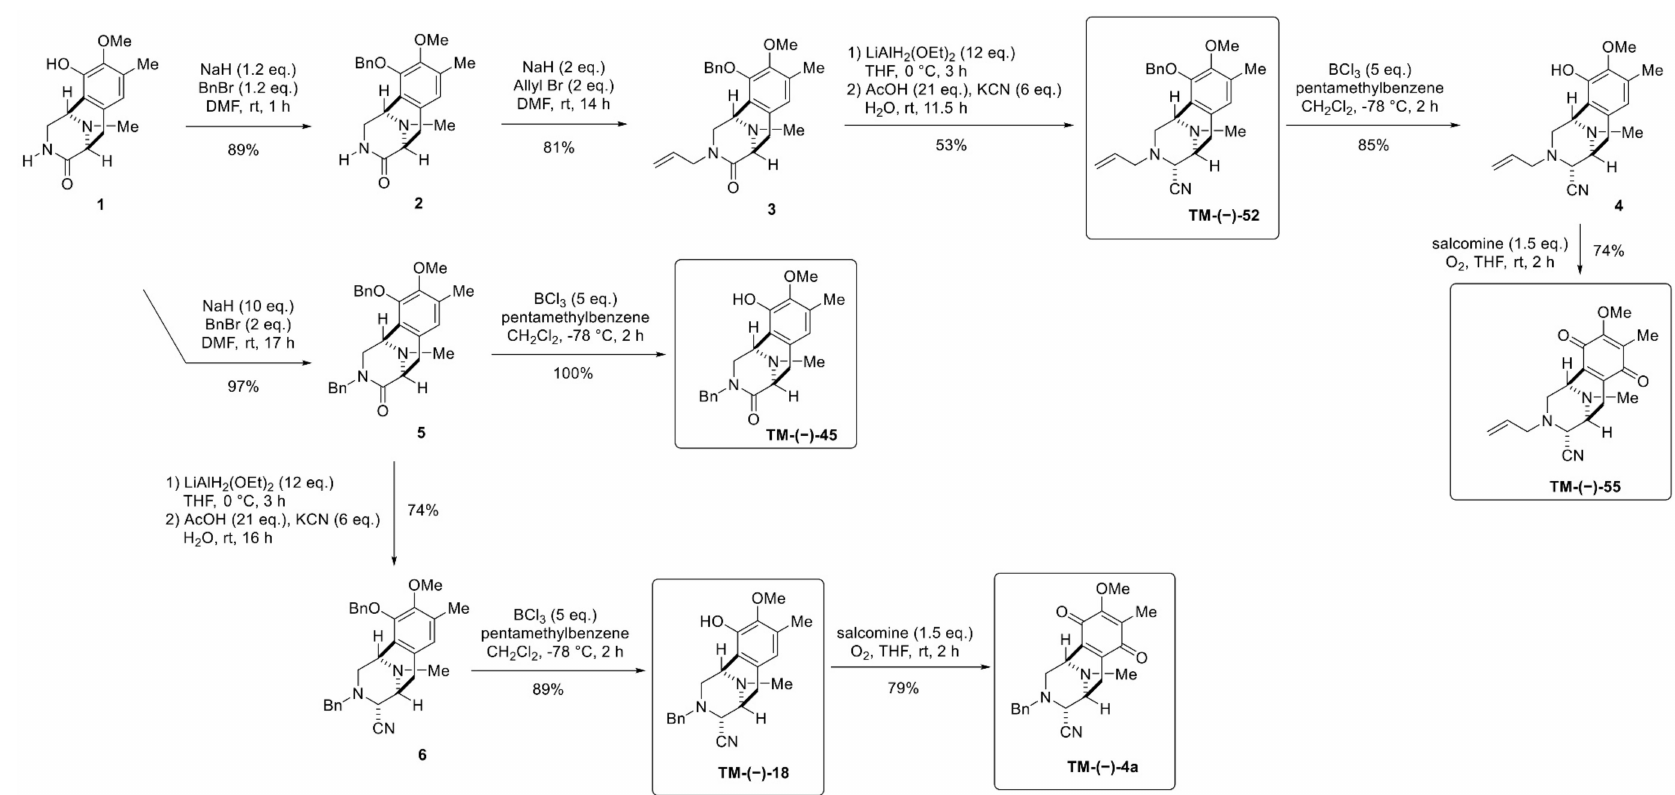
Figure 8. Simplified right-half model of RT compounds: TM-(–)-45, TM-(–)-18, TM-(–)-4a, TM-(–)-52, and TM-(–)-55 synthetic pathways. Compound 1 could be easily obtained from L-Tyr [65]. The phenol of compound 1 was selectively protected with 1.2 eq. of NaH and BnBr in DMF to give compound 2 . The alkylation of the lactam nitrogen of compound 2 with allyl bromide gave compound 3 in an 81% yield. The lactam carbonyl of compound 2 was partially reduced with LiAlH 2 (OEt) 2 in THF to generate the aminal, [66] which was then treated with KCN and H 2 O to give the α -aminonitrile TM-(–)-52 as a single diastereomer. Chemoselective debenzylation was achieved with BCl 3 in the presence of pentamethylbenzene to give the phenol. [67] Finally, oxidation of this obtained phenol using salcomine with O 2 a ff orded TM-(–)-55 in a 74% yield; whereas compound 2 was bisbenzylated with 2 eq. of benzylbromide in the presence of 10 eq. of NaH to give compound 5 in a 97% yield. The debenzylation of 19 by using BCl 3 gave the phenol TM-(–)-45. The reductive cyanation of compound 5 generated the aminonitrile compound 6 , which was chemoselectively debenzylated with BCl 3 to a ff ord TM-(–)-18 in an 89% yield. Finally, the phenol compound 5 was oxidized with salcomine in an oxygen atmosphere to give